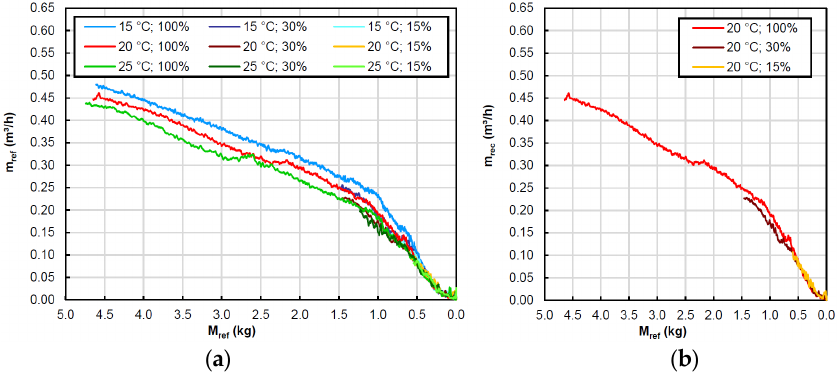
Figure 7. Flow rate variation by varying water content inside the evaporator for all tested conditions ( a ) and only for T chw , in = 20 ◦ C tests ( b